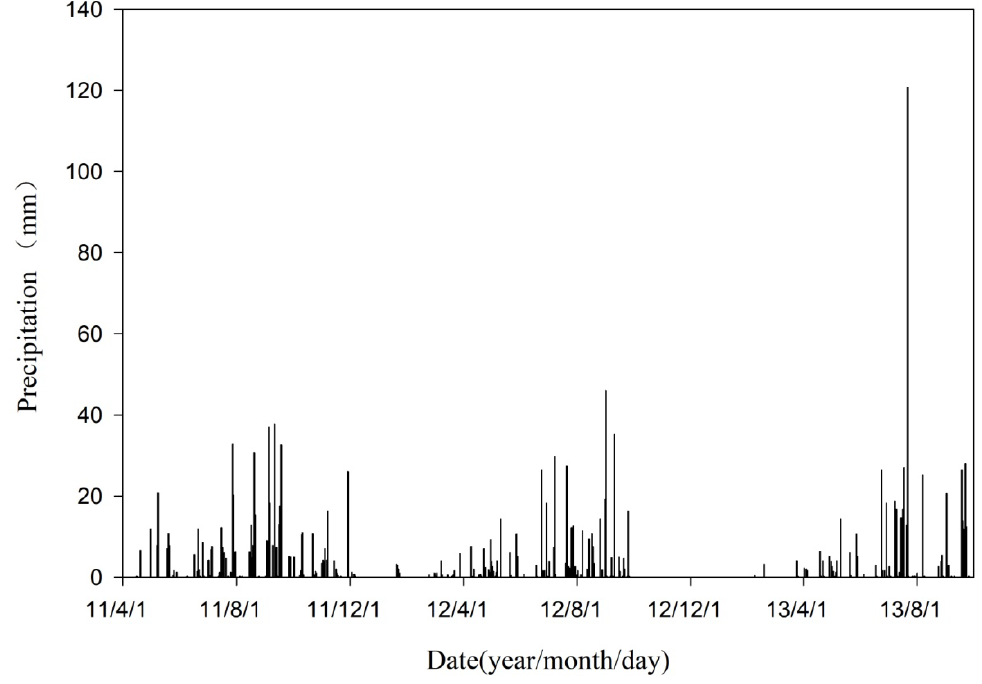
Figure 5. Daily precipitation (P) at the experimental site during 2011, 2012, and 2013. Table 1. The water consumption (mm) of maize under the non-mulched (CK), gravel mulching (GM), straw mulching (SM), and plastic film mulching (FM) treatments in 2011, 2012, and 2013. Before Spin- before Spinning after Spinning before Spinning/after Whole Growth Before Spin- Year Treatments After Spinning ning/After Spin- Period ning ning